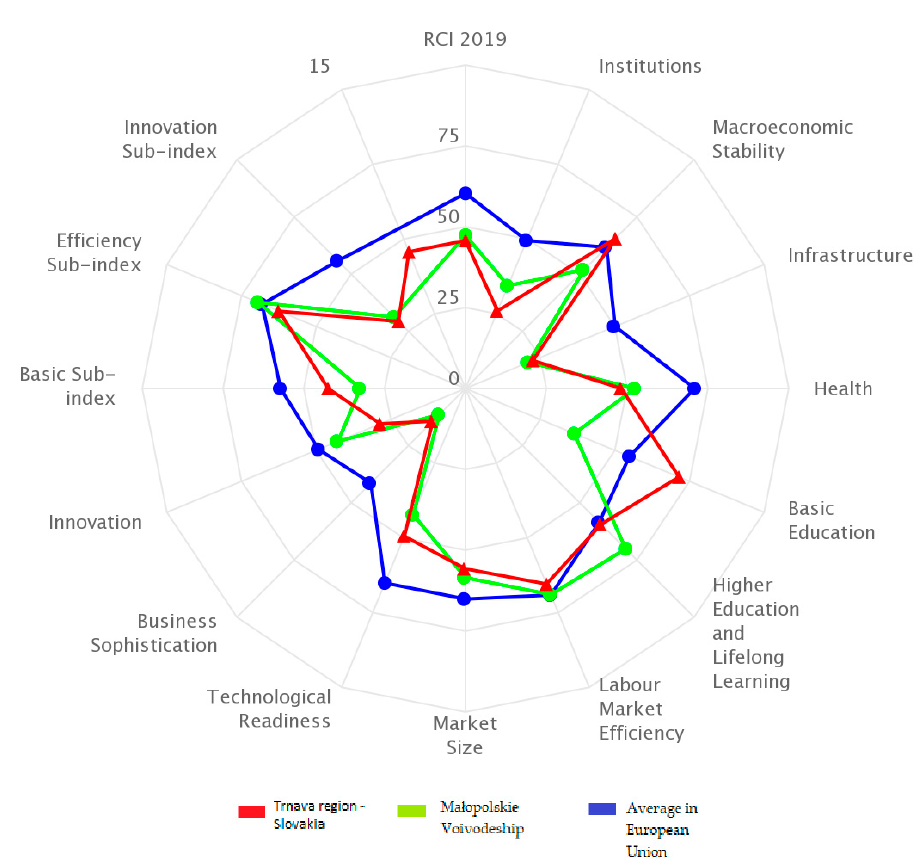
Figure 1. The comparison of the indicators of regional competitiveness index for Malopolska and the Trnava regions with the average in the European Union based on data from [24].